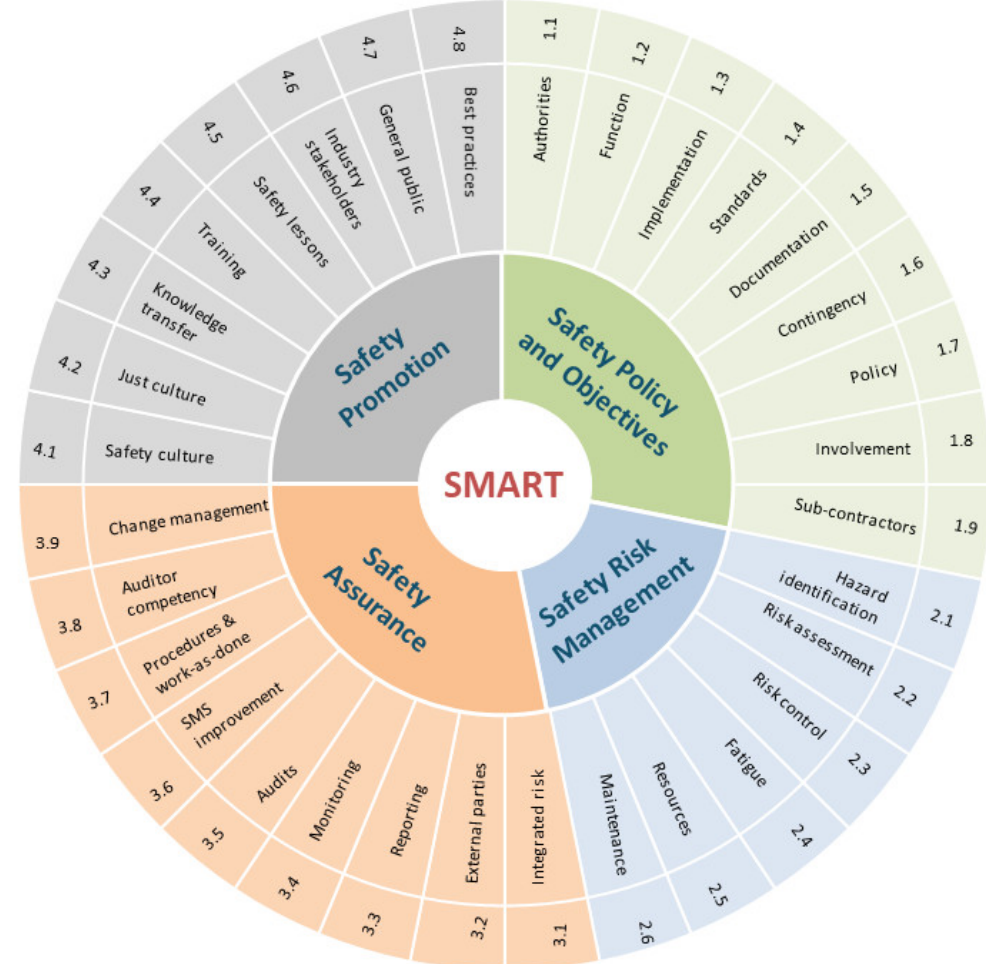
Figure 2. Topics in the SMS Maturity Assessment & Refinement Tool (SMART).